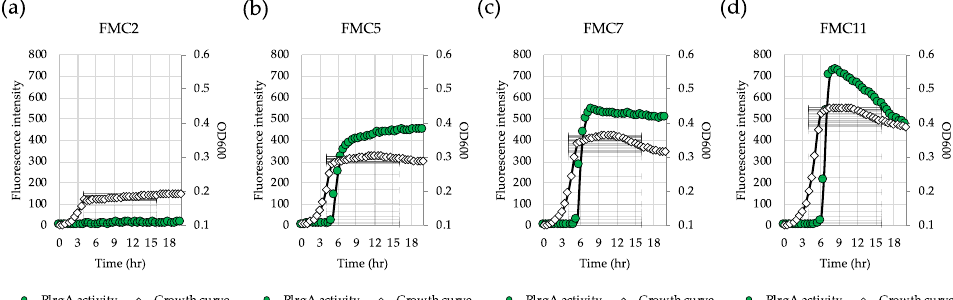
Figure 1. Low glucose dependence of P lrgA activity during growth in FMC medium. The P lrgA-gfp reporter strain in the S. mutans wild type background was grown in FMC medium, supplemented by 2 ( a ), 5 ( b ), 7 ( c ), and 11 mM ( d ) glucose. Relative gfp expression (green circle) and OD 600 (white diamond) were monitored during growth on a plate reader (see Materials and Methods for details). The results are representative of three independent